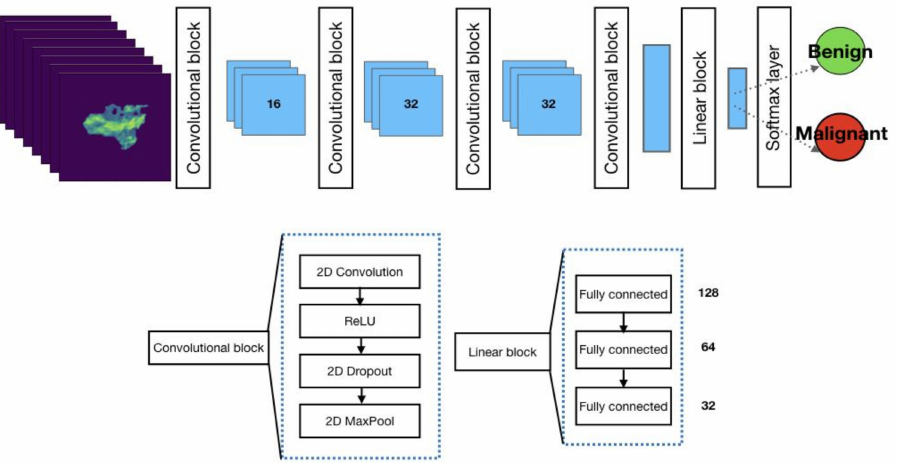
Figure 3. Architecture of the convolutional neural network used to classify lung nodules as benign or malignant. The number in each layer represents the number of output channels in that